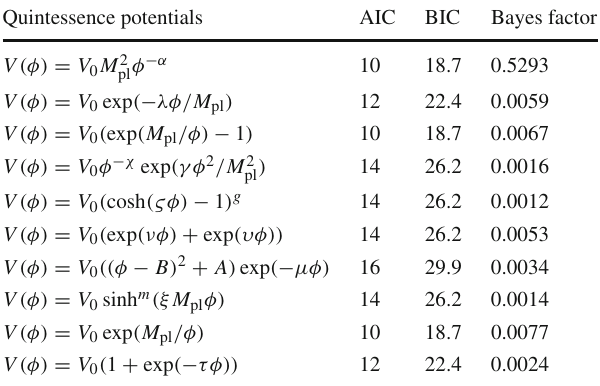
Table 4 The list of the dark energy phantom potentials, with corre- sponding AIC , BIC , and Bayes factor values Phantom